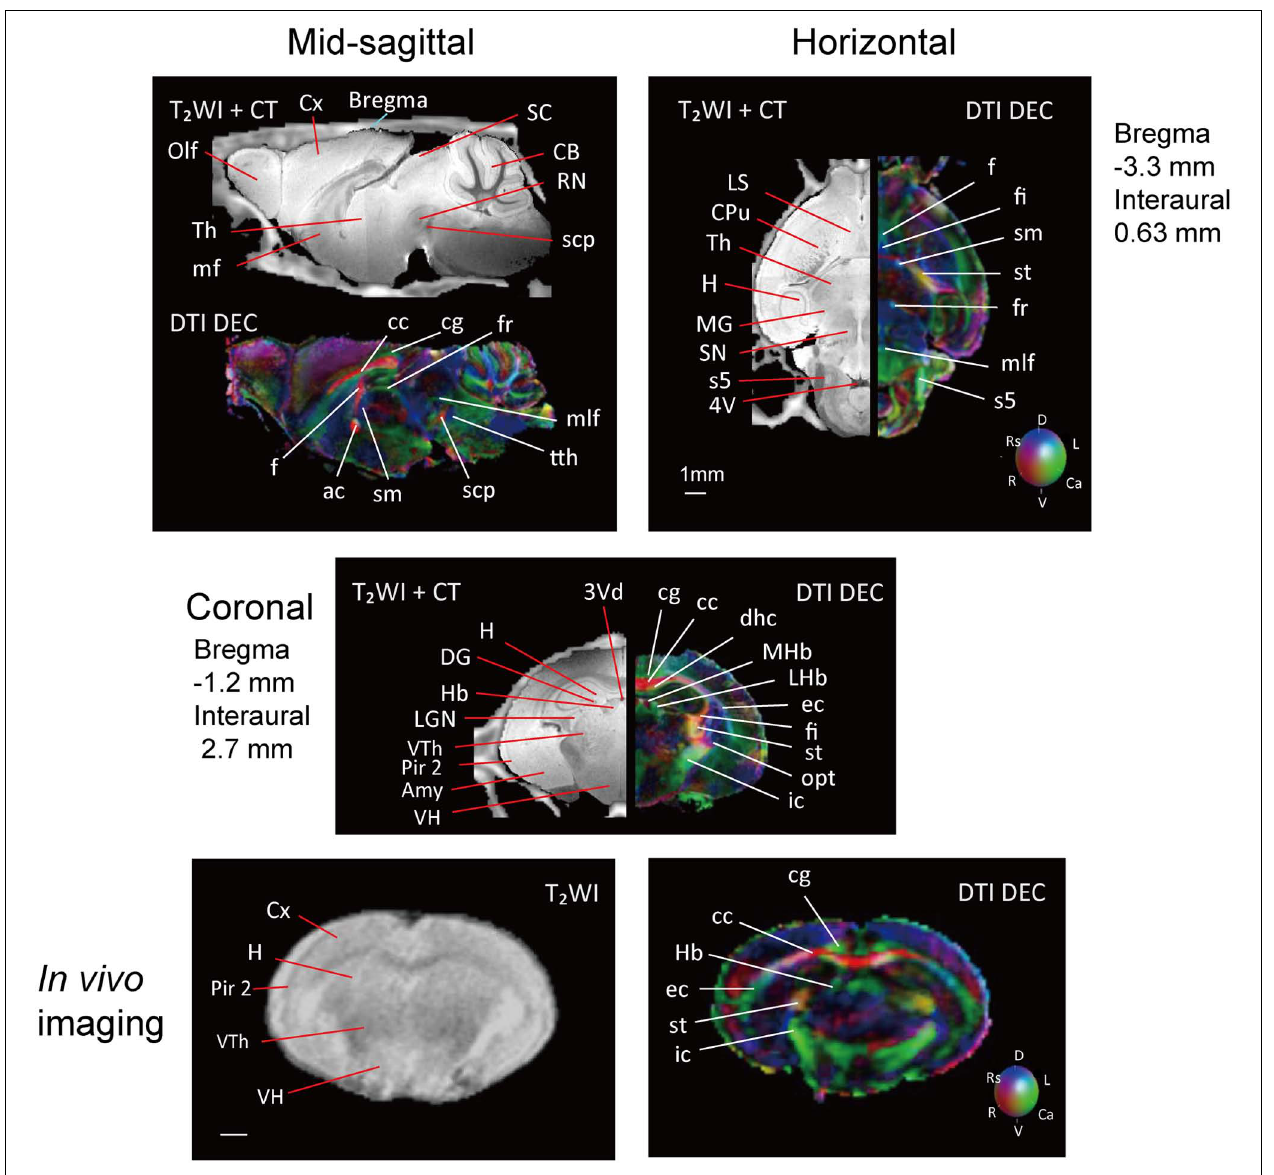
FIGURE 2 |T 2 WI and DTI. One slice from the atlas: the sagittal (upper left), horizontal (upper right), and coronal planes (center). One coronal slice from in vivo T 2 WI (lower left) and DTI (lower right). Orientation is coded by color as follows: red is medial–lateral, green is rostral–caudal, and blue is dorsal–ventral. Scale bar = 1